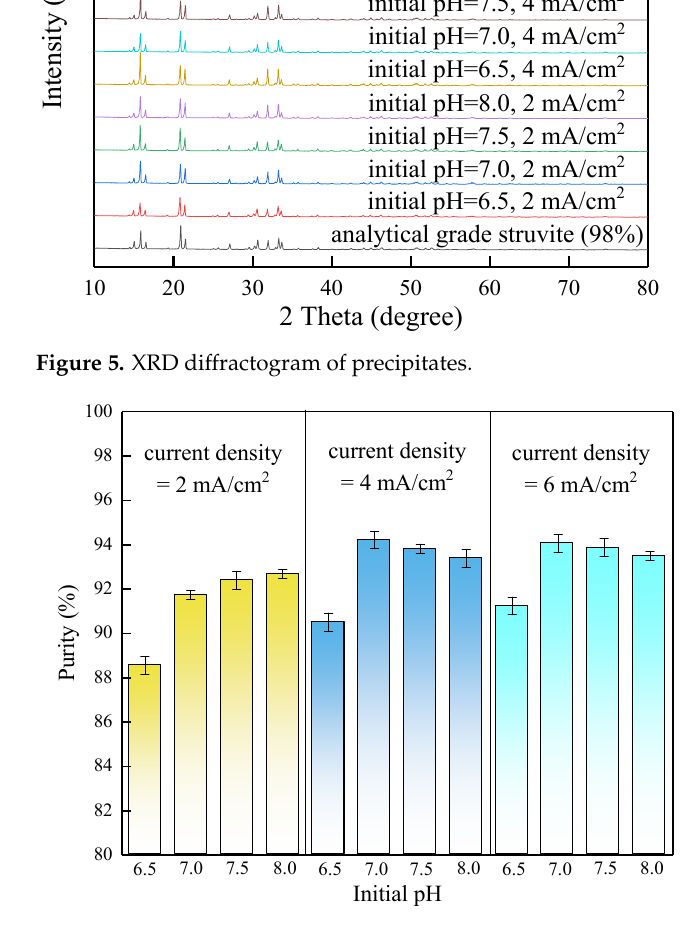
Figure 6. Struvite purity in the precipitates.